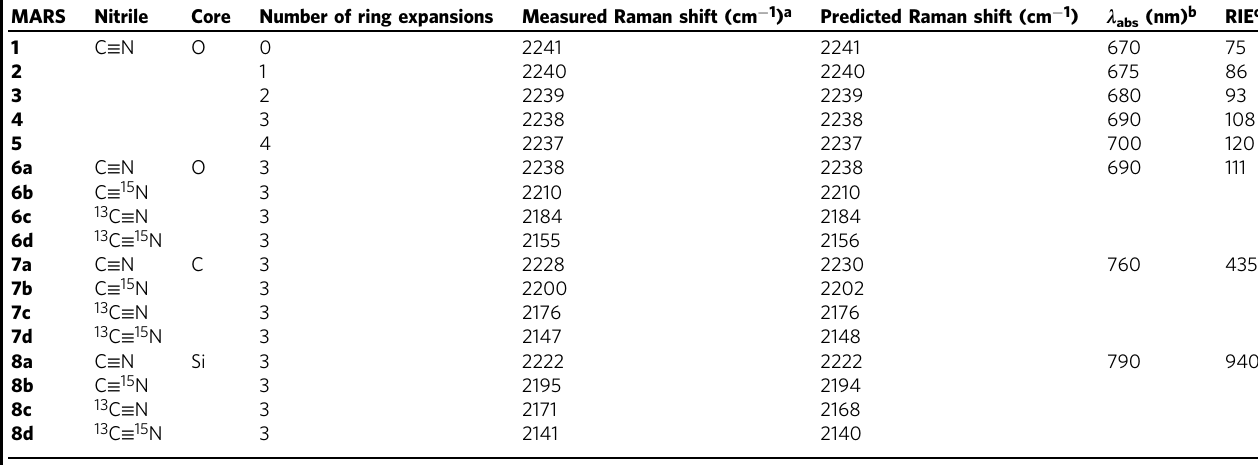
Table 1 Photophysical properties of newly synthesized MARS model compounds. MARS